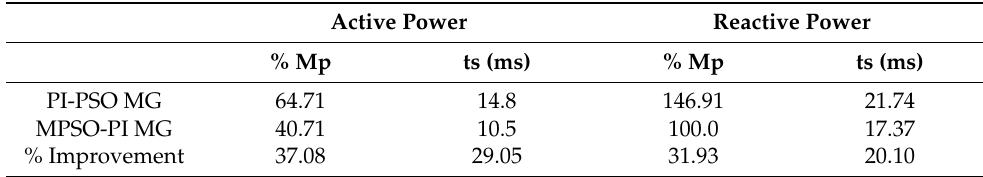
Table 4. Transient response analysis for D.G. injection.